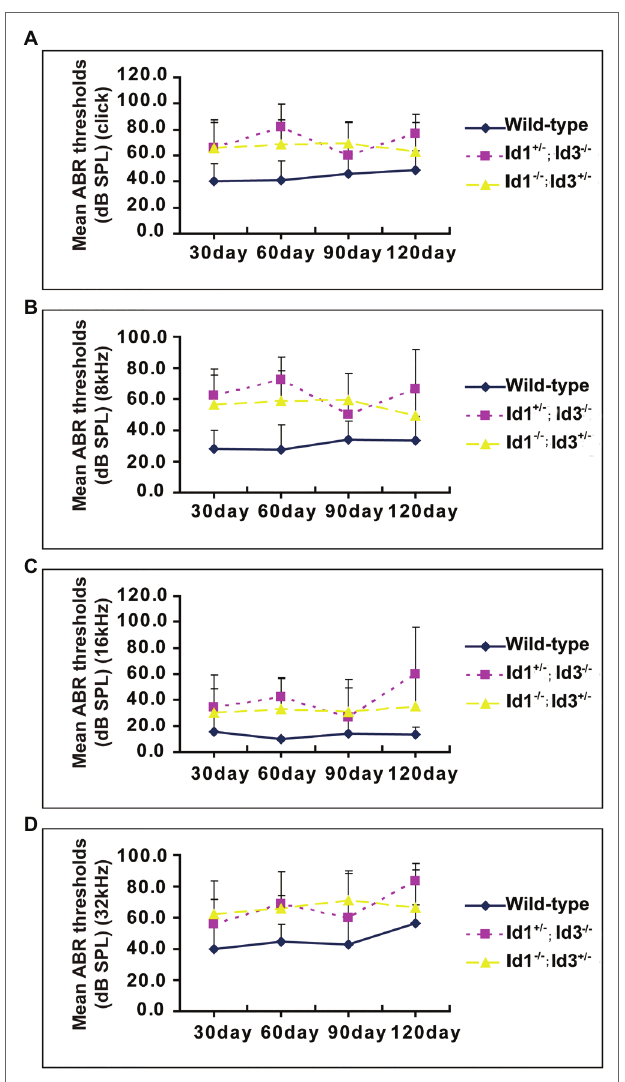
FIGURE 2 | A time-course observation of the ABR thresholds in the right ears of Id1 − / − ; Id3 +/ − and Id1 +/ − ; Id3 − / − mice and littermate control mice. All mice of ages from P30 to P120 and the individual ABR thresholds at all stimulus frequencies of click (A) , 8 (B) , 16 (C) , and 32 kHz (D) were variable, but the overall tendency was relatively stable at each stimulus frequency compared with the ABR thresholds of the control mice. The error bars indicate SD from the mean at each time point for each mouse